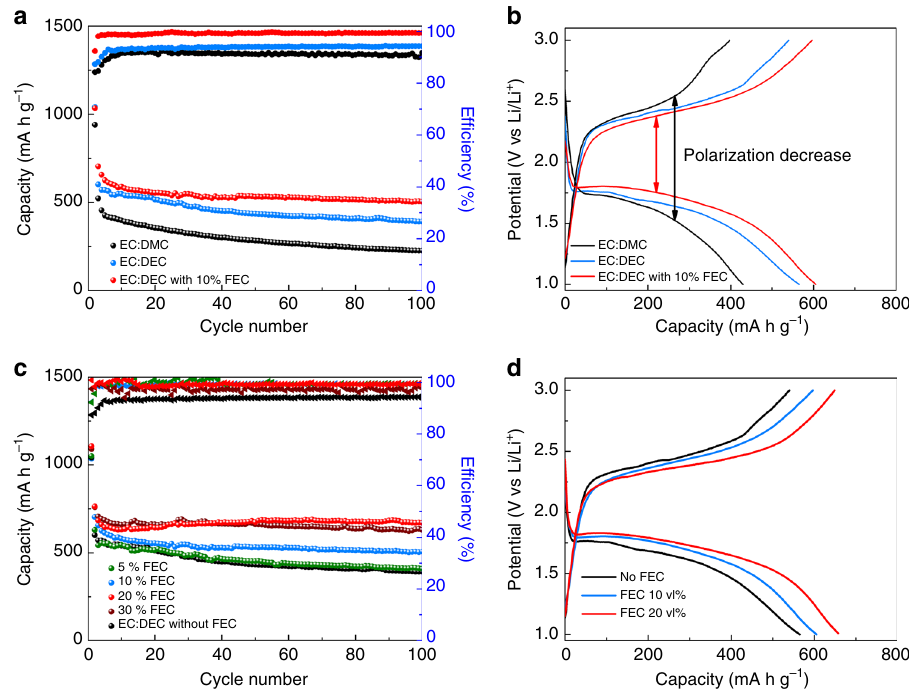
Fig. 3 Optimization of electrolyte compositions for carbonate lithium – sulfur batteries. a , b Electrochemical performance of lithium – sulfur batteries with different carbonate electrolyte systems. The employed carbonate electrolyte systems are 1 M LiPF 6 in (black line) ethylene carbonate (EC) and dimethyl carbonate (DMC) with volume ratio of 1:1; (blue line) EC and diethyl carbonate (DEC) with volume ratio of 1:1; (red line) EC:DEC with 10 vol% fl uoroethylene carbonate (FEC) additive. c , d Electrochemical performance of lithium – sulfur batteries with various ratios of FEC additive from 0 to 30 vol% in carbonate electrolyte (1 M LiPF 6 ,